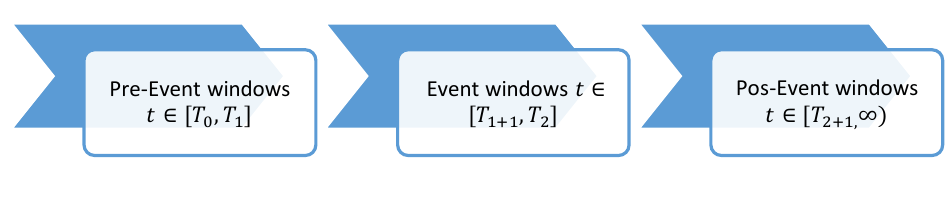
Figure 1. Event Studies Scheme.